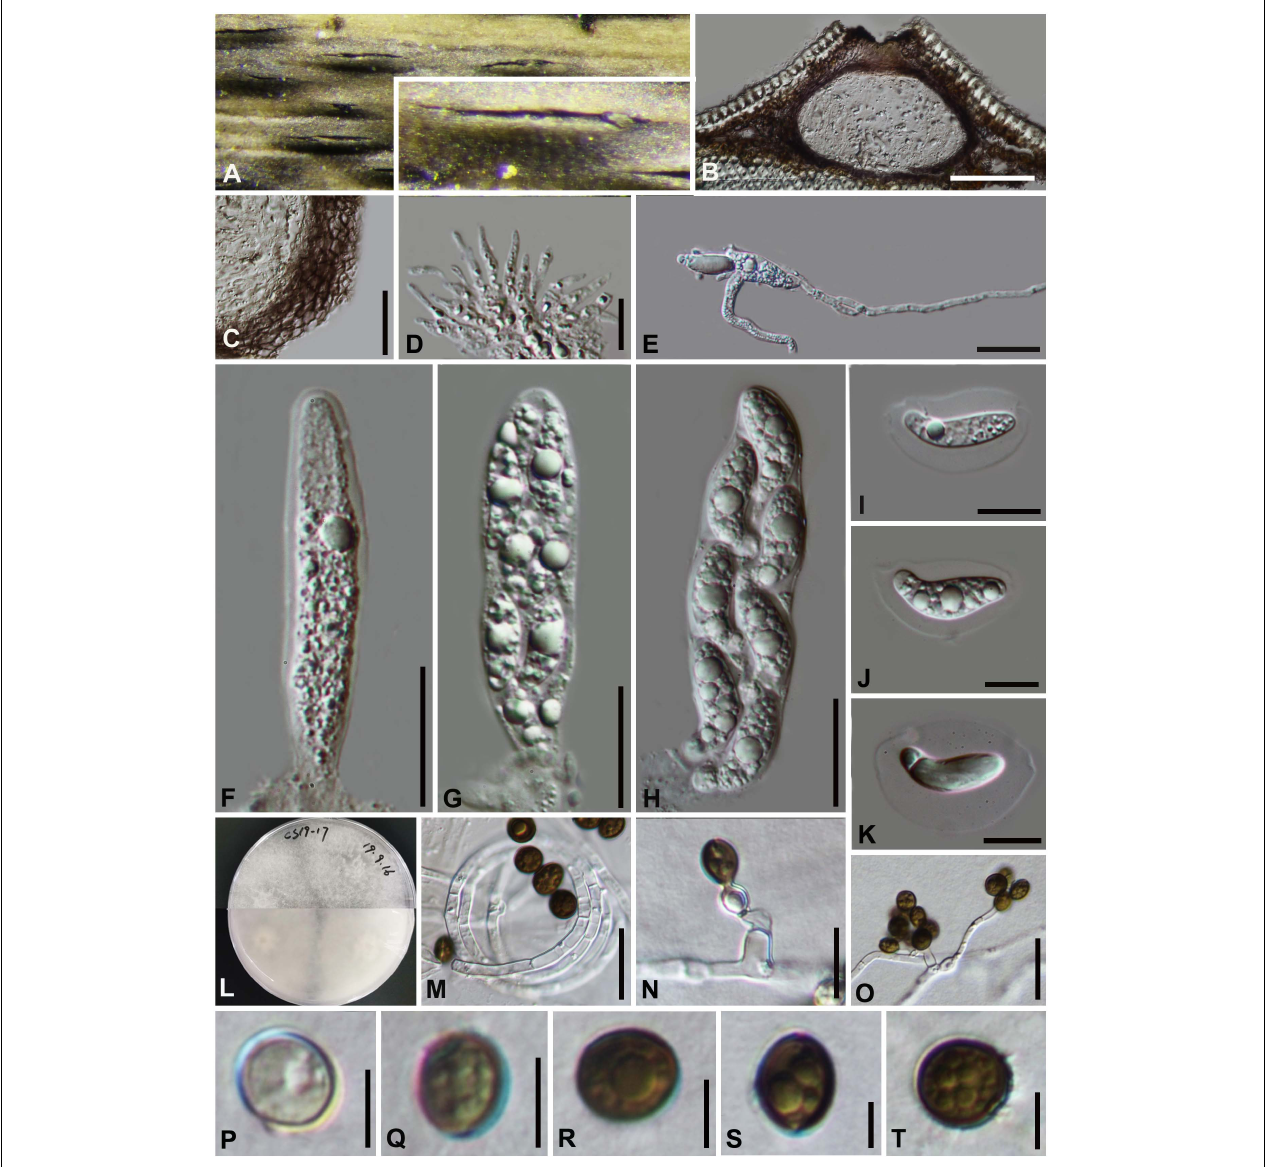
FIGURE 2 | Arthrinium biseriale (HKAS 111961 , holotype ). (A) Appearance of stromata on bamboo host. (B) Vertical section of stroma. (C) Peridium. (D) Paraphyses. (E) Germinating ascospore. (F–H) Asci. (I–K) Ascospore. (L) Culture. (M) Hyphae. ( N , O) Conidiophore and conidiogenous cells. ( P–T) Conidia. Scale bars: (B) = 50 µ m. (C) = 20 µ m. (D) = 10 µ m. (E–H) = 20 µ m. (I–K) = 10 µ m. (M) = 20 µ m. (N) = 10 µ m. (O) = 20 µ m. (P–T) = 5 µ m.